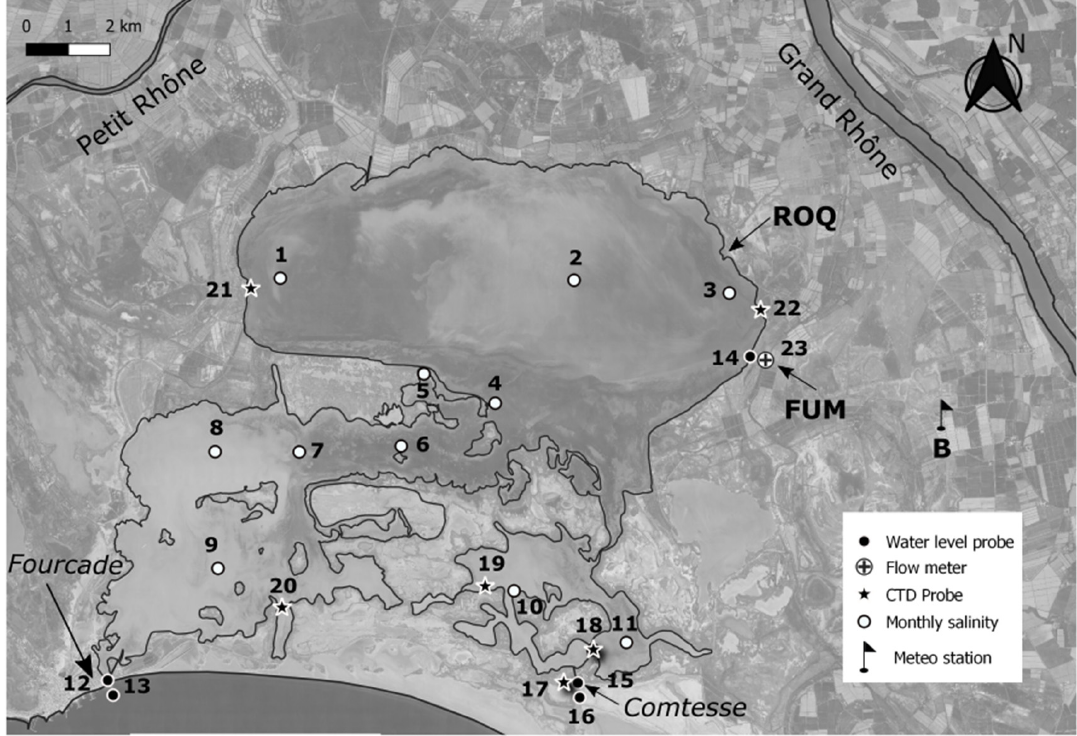
Figure 2. Localization of salinity, water level, and water flow measurements used in this study.